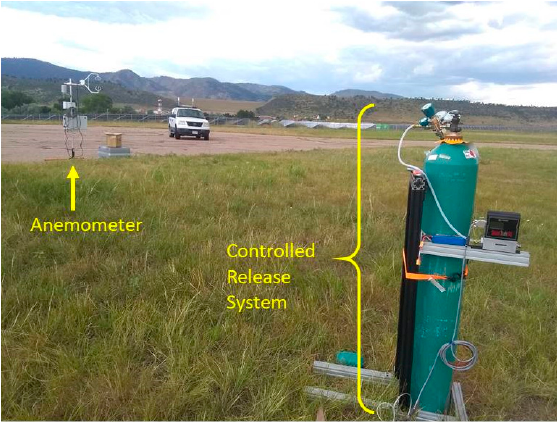
Figure 3. Photograph of controlled release setup.